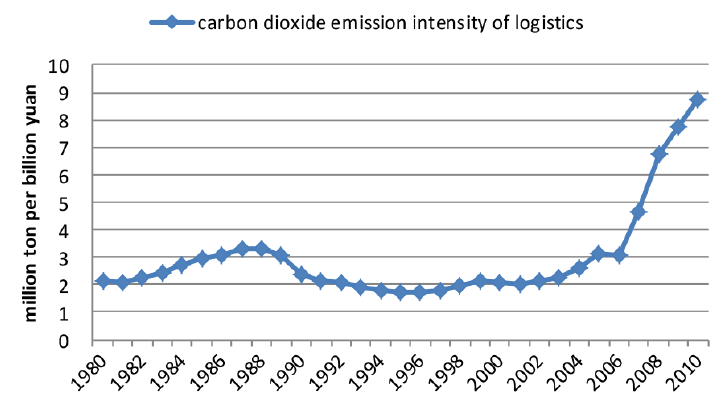
Figure 4. CO 2 emission intensity of logistic industry